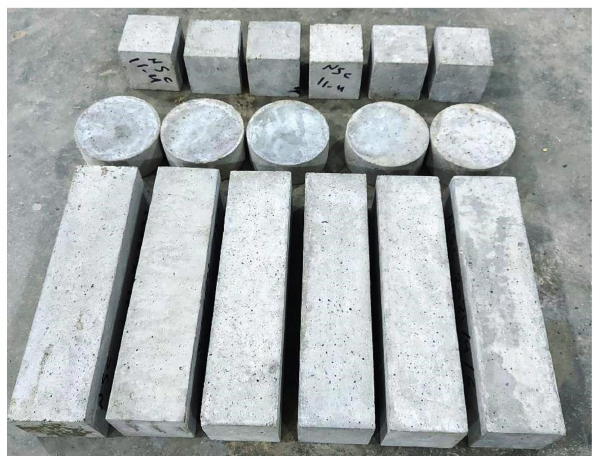
Figure 3. Single group of disc, cube and prism specimens.